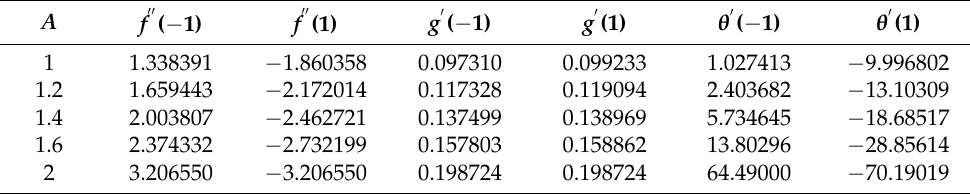
Table 6. Shear stresses, couple stresses, and heat transfer rate for different A